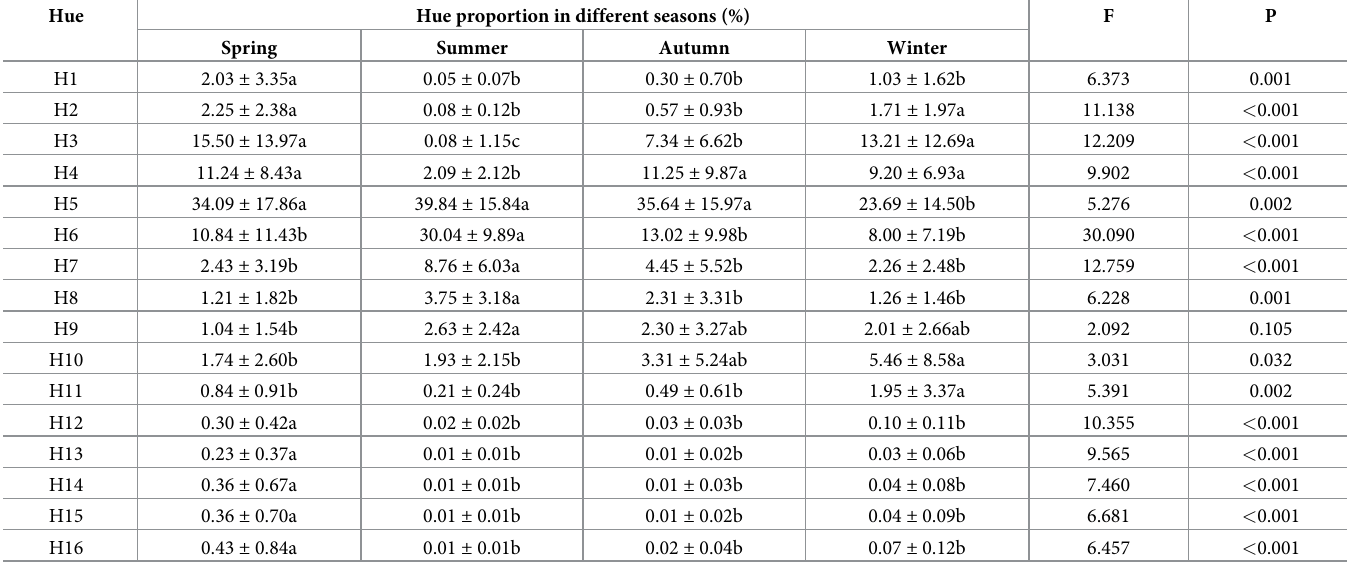
Different letters indicate significant differences at the 0.05